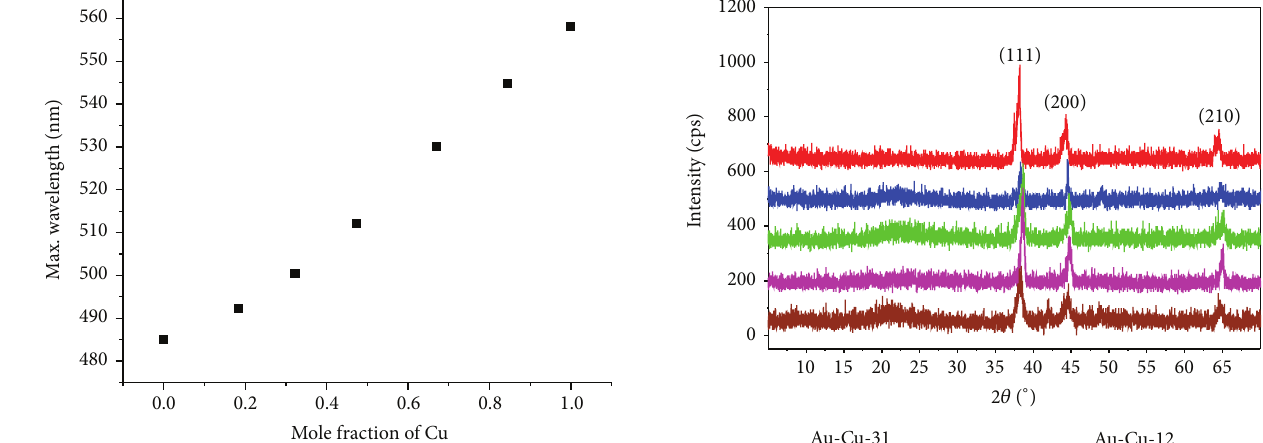
Figure 5: Plot of Max. wavelength versus mole fraction of Cu in Au- Cu alloy nanoparticles.